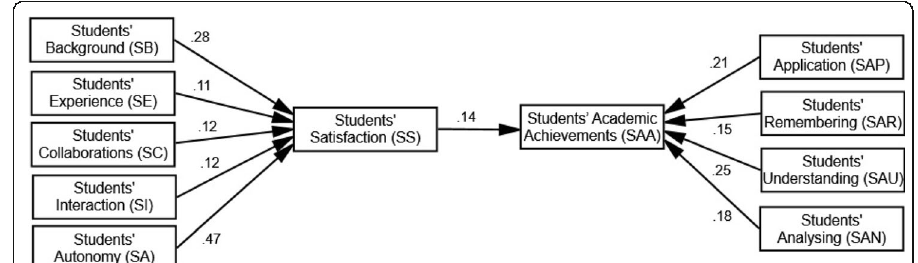
Fig. 4 Findings for the Proposed Model T.Values